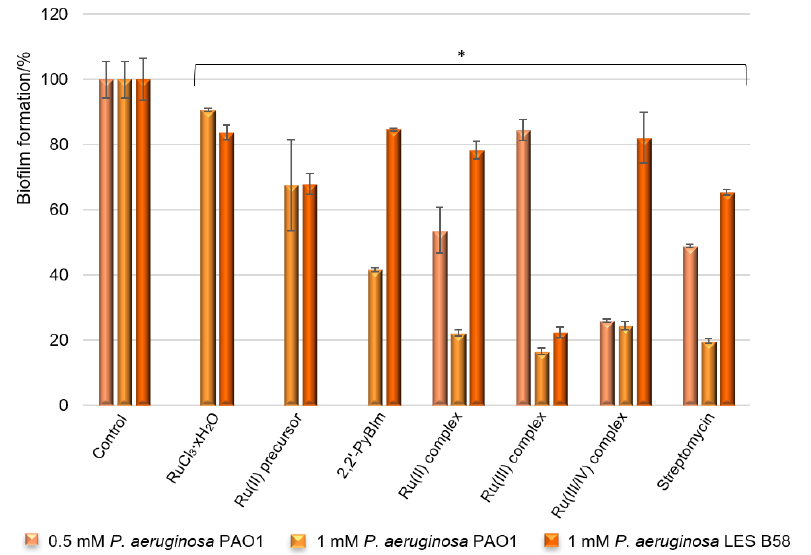
Figure 7. P. aeruginosa PAO1 and LES B58 biofilms formation in the presence of RuCl 3 · xH 2 O, Ru(II) precursor, free ligand, and Ru complexes (concentrations of compounds—0.5 and 1 mM). The absorbance of the control was considered to represent 100% of biofilm formation (results were considered significant when compared to control; * p < 0.05. Data are presented as mean ± SD, n = 4). According to the results of the tests, the ruthenium complexes showed a significant reduction in the P. aeruginosa PAO1 biofilm formation. The Ru compounds were able to inhibit the biofilm formation, reducing the biomass by 83% (the Ru(III) complex), 78% (the Ru(II) complex), and 75% (the Ru(III/IV) complex) when the concentration was 1 mM. Thus, the activity of the compounds is comparable at this concentration. It is worth noting that these values are similar to those obtained for the reference standard being evalu- ated—streptomycin. The results also demonstrated that the free ligand (2,2′-PyBIm) ex- hibited moderate effectiveness at the tested concentration, and was less active than its ruthenium complexes. Decreasing the concentration of the added ruthenium compounds (0.5 mM) prompted a lower level of reduction in the biofilm formation of the P. aeruginosa PAO1 strain in the case of the Ru(II) and the Ru(III) complexes. These complexes were able to inhibit the biofilm formation, reducing the biomass by 46% and 15% at the tested concentration, respectively. Interestingly, more than 70% of the biofilm biomass formed by the PAO1 was inhibited at both 0.5 mM and 1 mM concentrations of the Ru(III/IV)